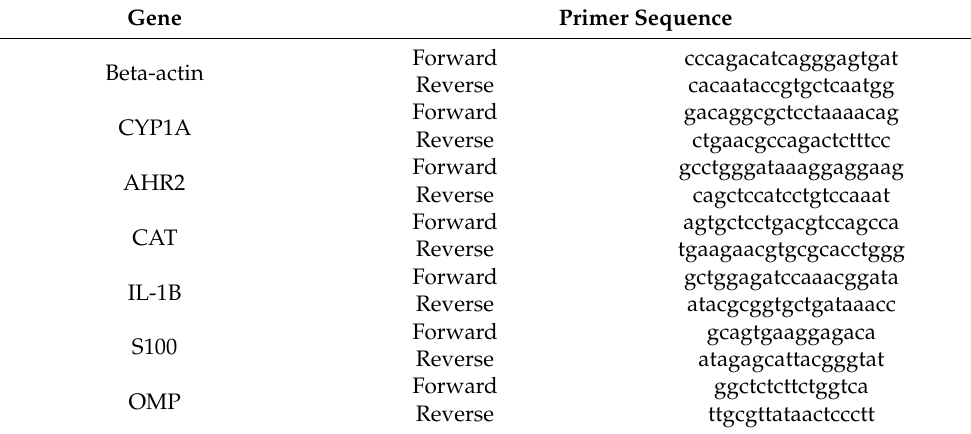
Table 3. List of primers for qRT-PCR. Sequences are given from 5 (cid:48) to 3 (cid:48) . Normalized gene (beta-actin). PAHs exposure related gene ( AHR2 and CYP1A ). Oxidation related gene ( CAT ). Olfactory sensory neurons related gene ( OMP and S100 ). Gene Primer